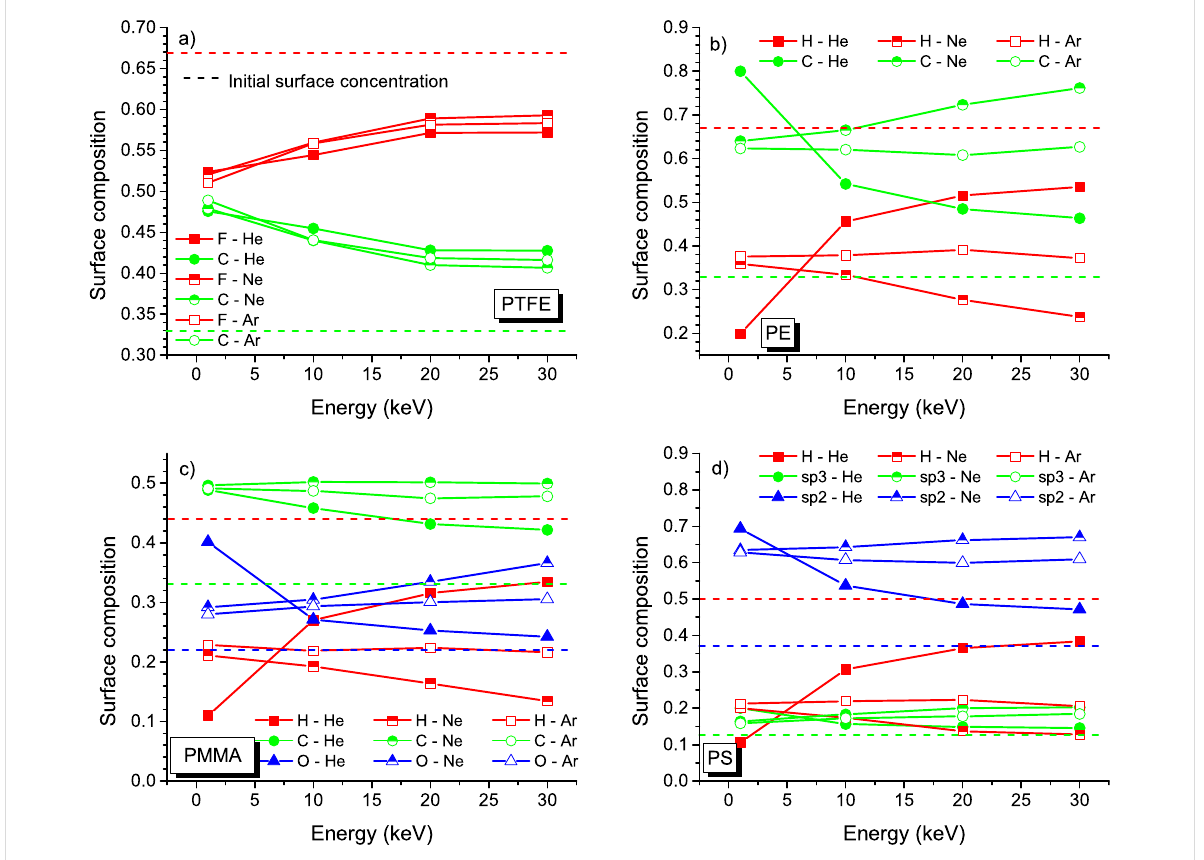
Figure 11: Surface composition as a function of impact energy for helium, neon and argon bombardment of a) F and C for PTFE, b) H and C for PE, c) H, C and O for PMMA, and d) H, C-sp 3 and C-sp 2 for PS. The results have been obtained by SD_TRIM_SP simulations for a fluence of 10 18 ions/cm 2